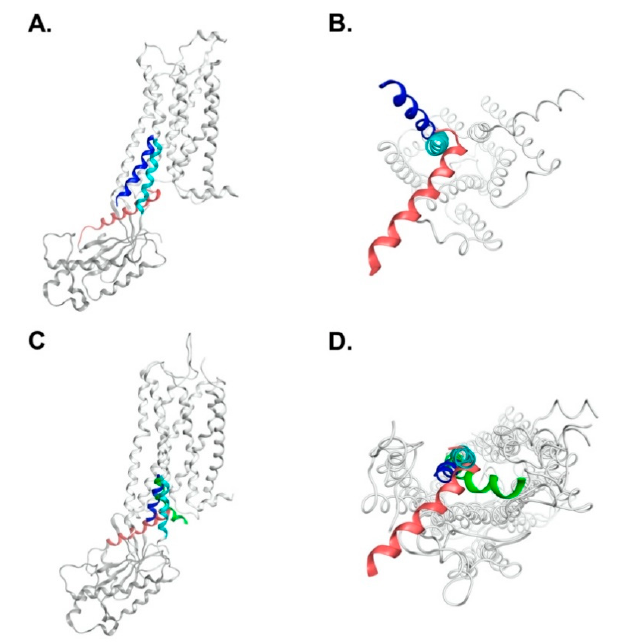
Figure 5. Homology modeled complex structures for A 2A AR-G α s and AVPR2-G α s systems. ( A ) Side view and ( B ) bottom view of A 2A AR complexed with the Ras domain of G α s . For A 2A AR, cyan: TM6 at inactive state; blue: TM6 at active state. For Ras-G α s , α 5-helix: light red. In the inactive state of A 2A AR, the TM6 may have steric repulsion with α 5-helix to inhibit G α s binding. ( C ) Side view and ( D ) bottom view of AVPR2 complexed with the Ras domain of G α s . For AVPR2, cyan: initial time; blue: 1500 ns; green: AVPR2- Δ V279. For Ras-G α s , α 5-helix: light red. α 5-helix of G α s -protein may have strong steric repulsion with TM6 of the inactive AVPR2- Δ V279.